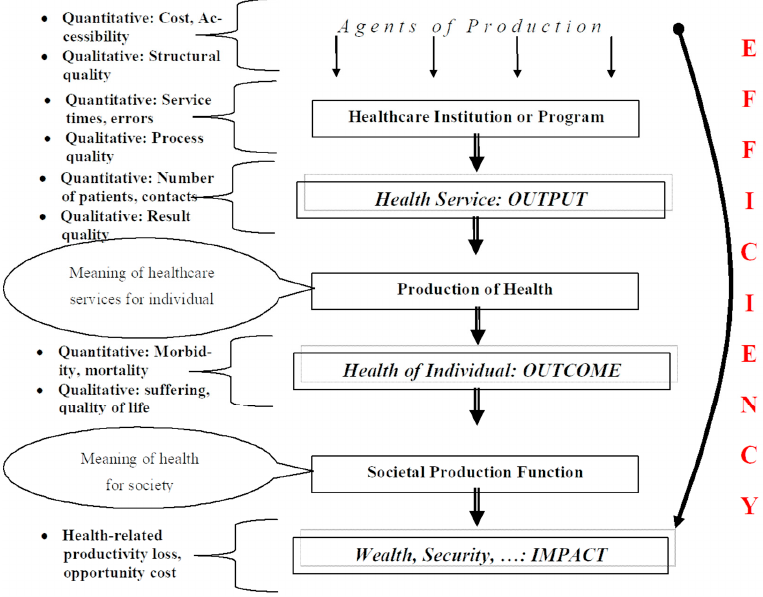
Figure 1. Health economic production and efficiency. Source: own, based on [10].